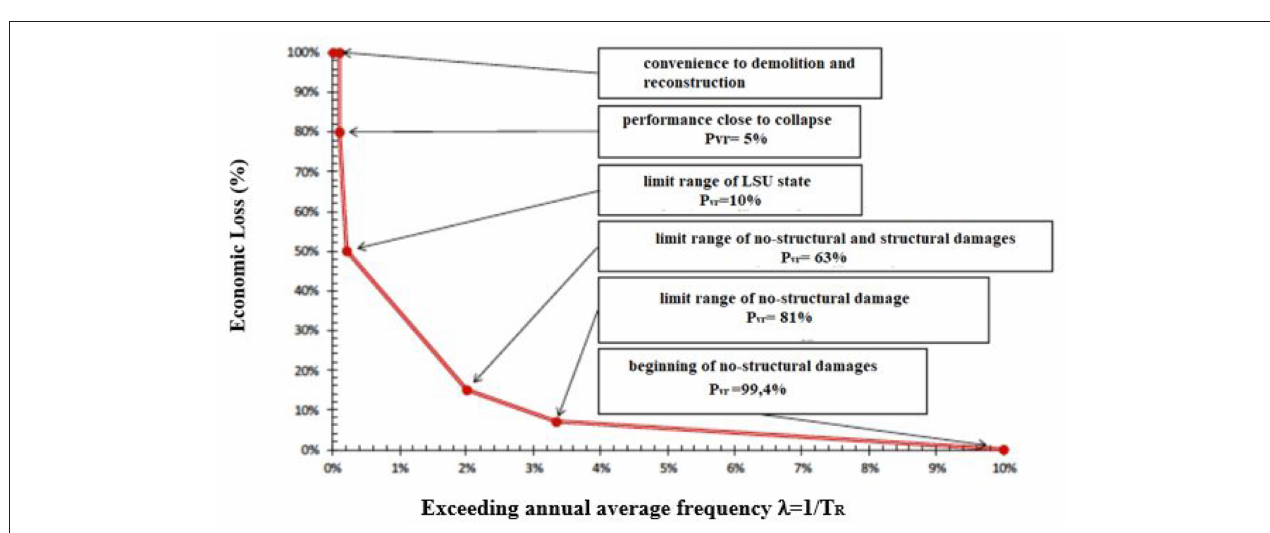
FIGURE 11 | The PAM index